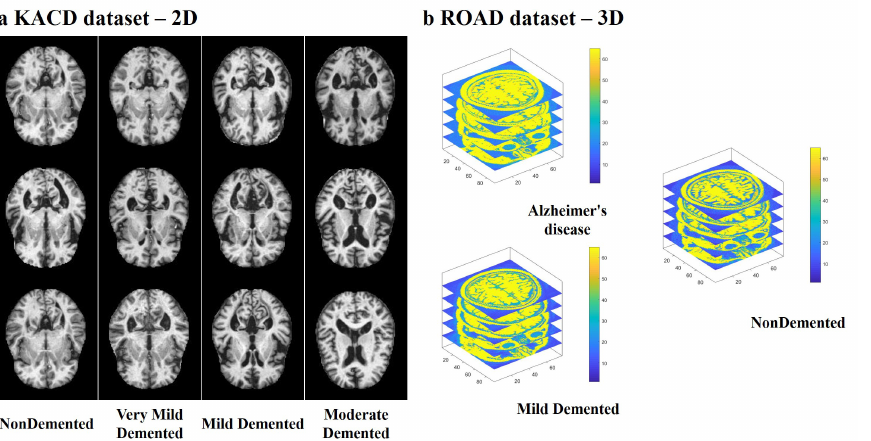
Figure 4. Examples of multi-modal data; ( a ) magnetic resonance imaging (MRI) images (2D) from the KACD dataset, ( b ) MRI images (3D) from the ROAD